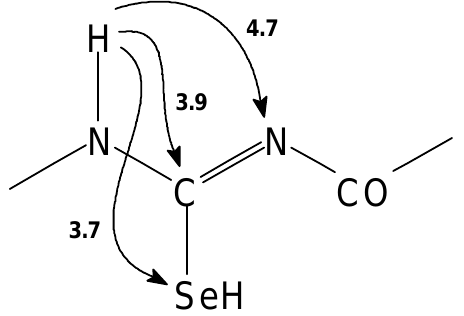
Figure 5. The nonoptimized long range 1 H- 13 C, 1 H- 15 N and 1 H- 77 Se interactions [Hz] observed for the basic skeleton part of acylisoselenourea 7 .